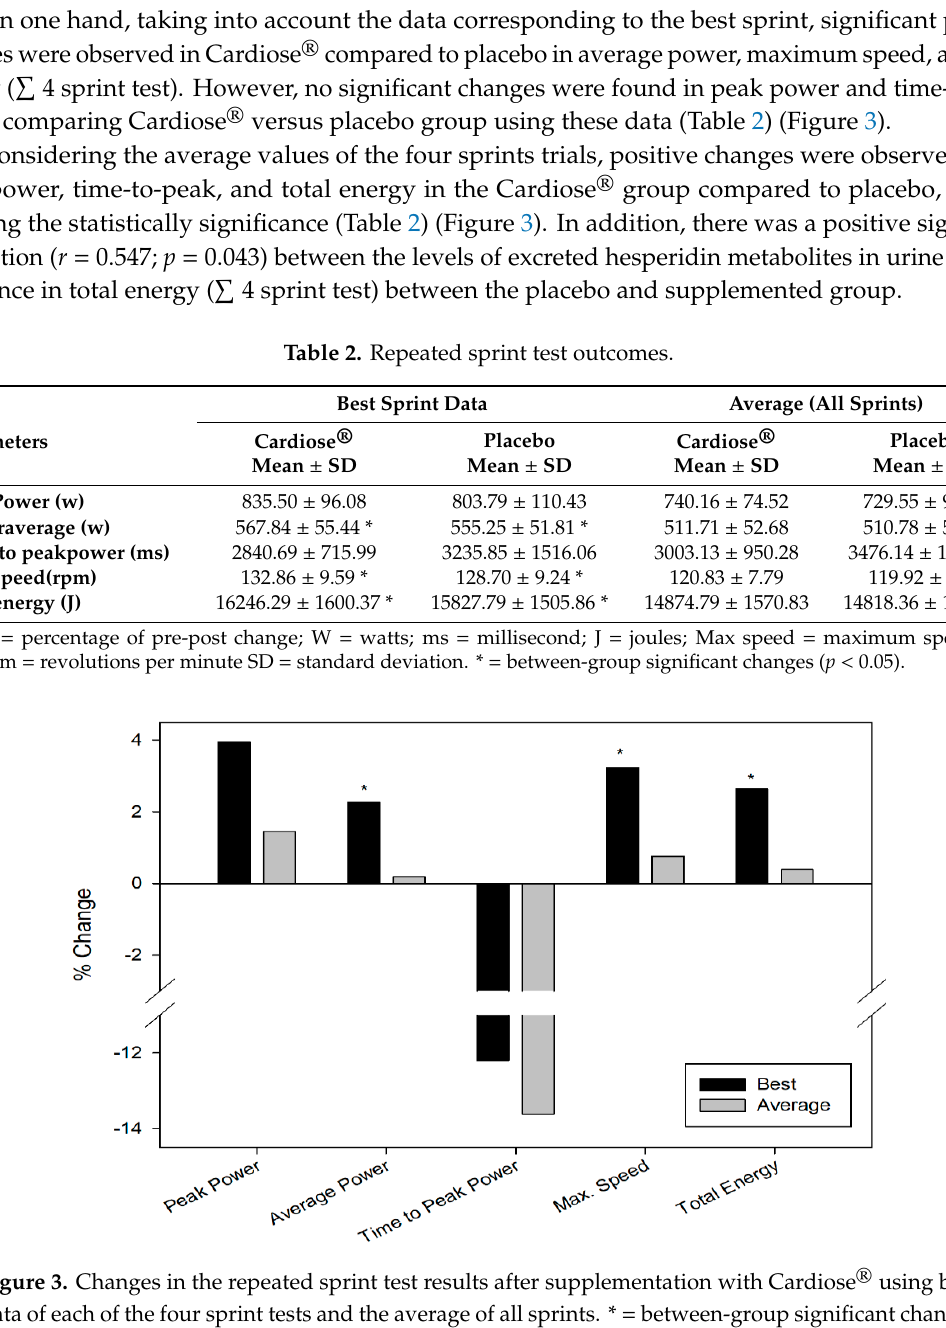
Table 2. Repeated sprint test outcomes. 303